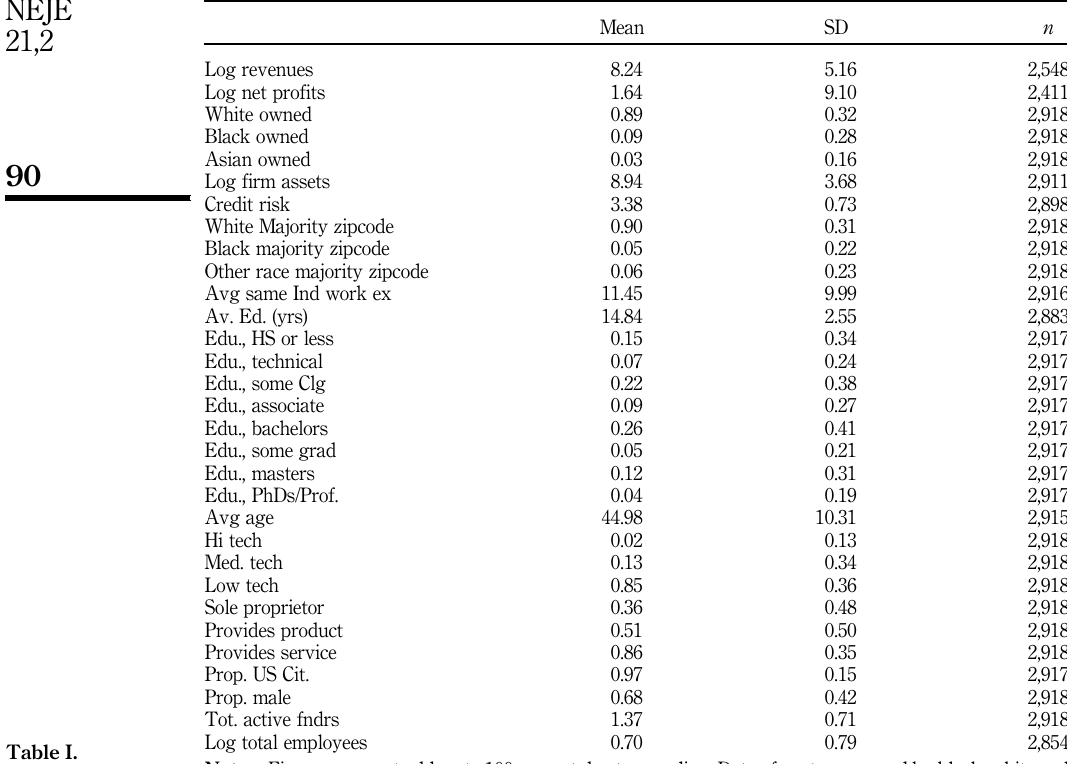
of variables in econometric models (2004 values